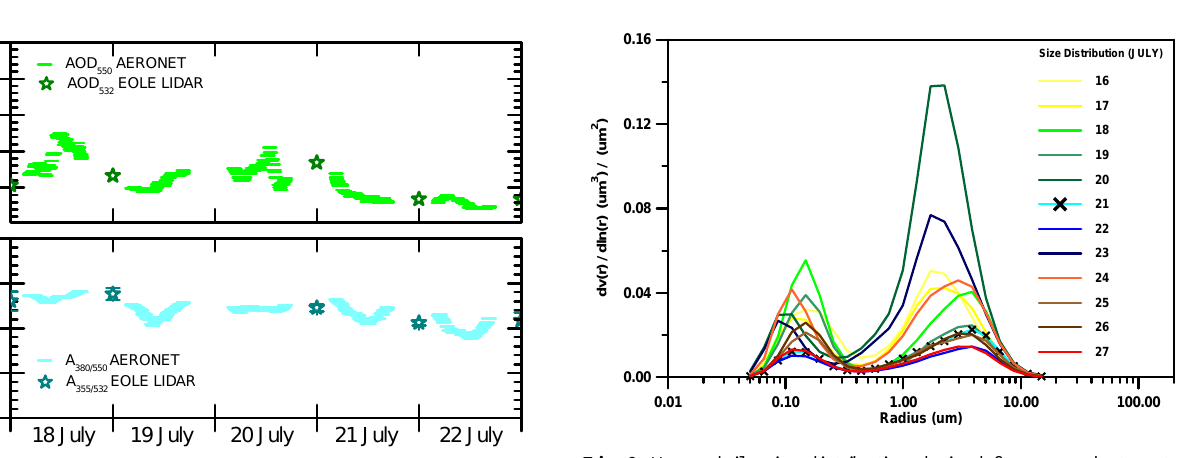
Fig. 9. Mean daily size distribution derived from sun photometer data obtained over Athens for the period 18–27 July 2009. The cross mark denotes the studied day (21 July